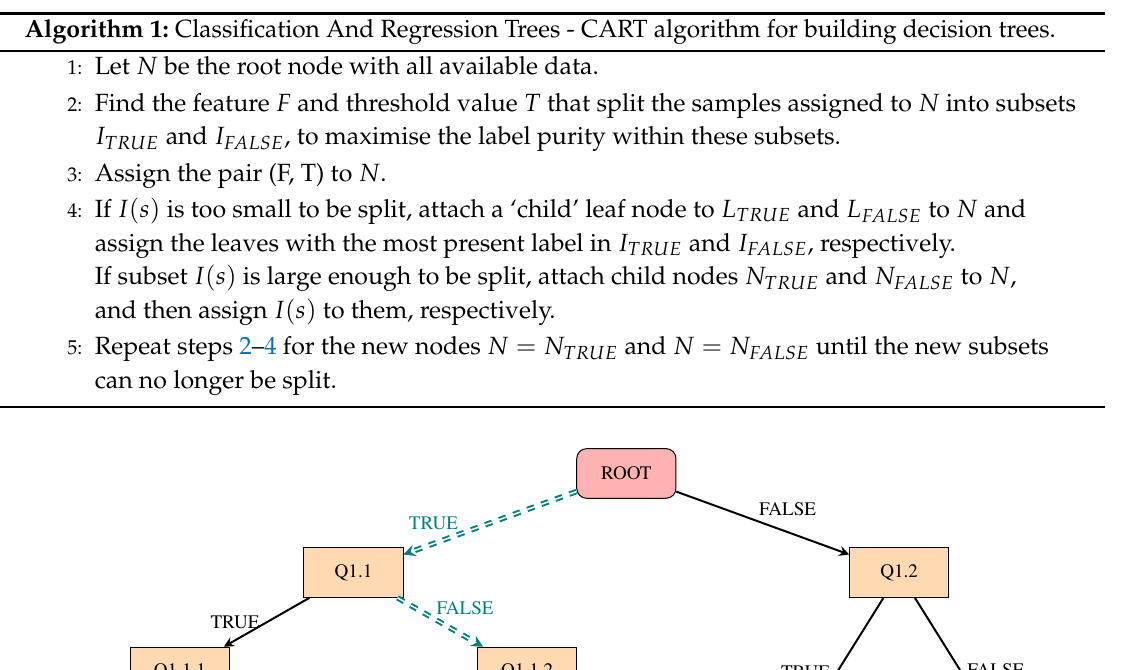
Algorithm 1: Classification And Regression Trees - CART algorithm for building decision trees.